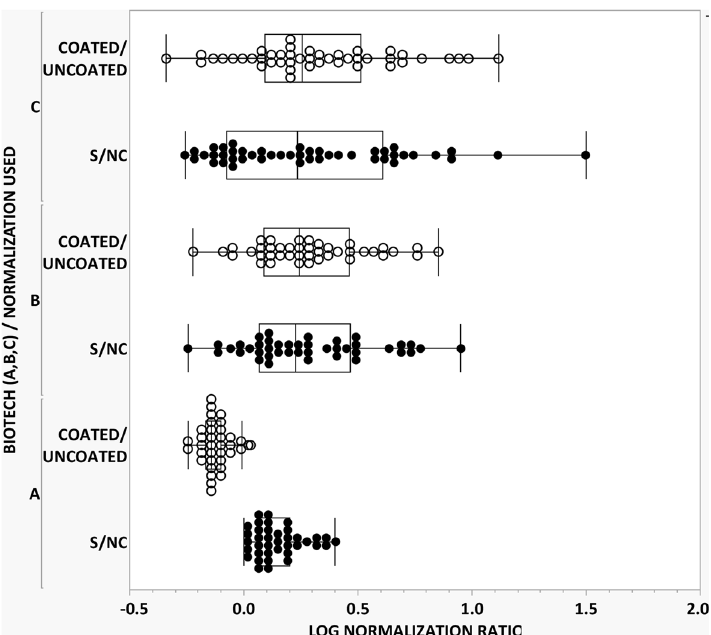
Figure 4. Comparison of different data transformation strategies for normalization of ADA signal responses. Three candidate biotherapeutic drugs were evaluated for determination of an ADA screening cut point. Individual signal responses were normalized by both the conventional approach involving S/NC (closed circle) and the modified approach using coated/uncoated wells (open circle) and then subjected to one round of outlier removal using box plot analysis (JMP, SAS institute, ver. 15.2.1). Results are reported in Table 1. As shown above the data transformation involving coated/uncoated wells yielded superior distributional normality with decreased